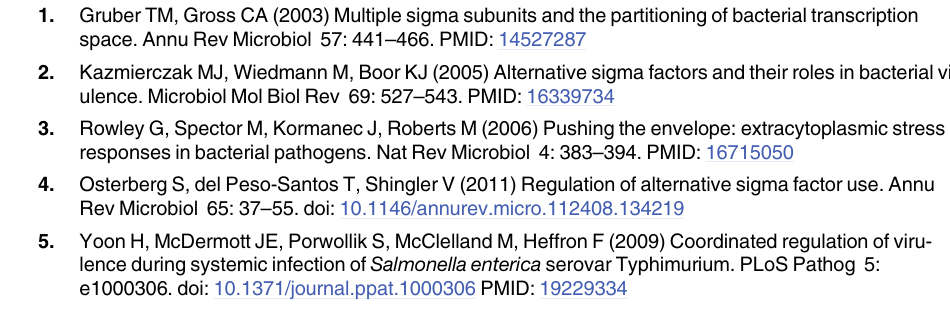
S1 Table. List of primers used for mutant construction. S2 Table. List of quantitative PCR primers used in this